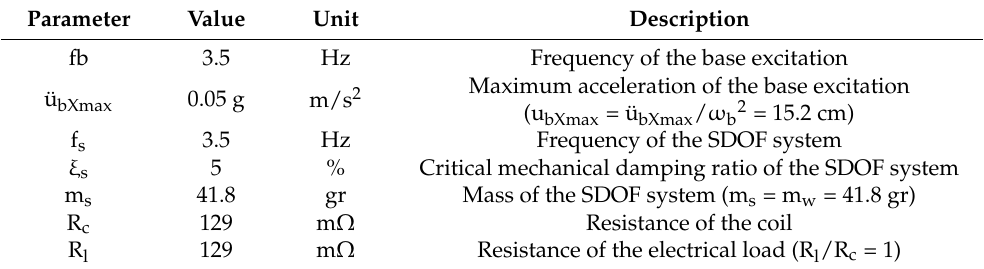
Table 2. Parameters of the SDOF model developed in MATLAB.